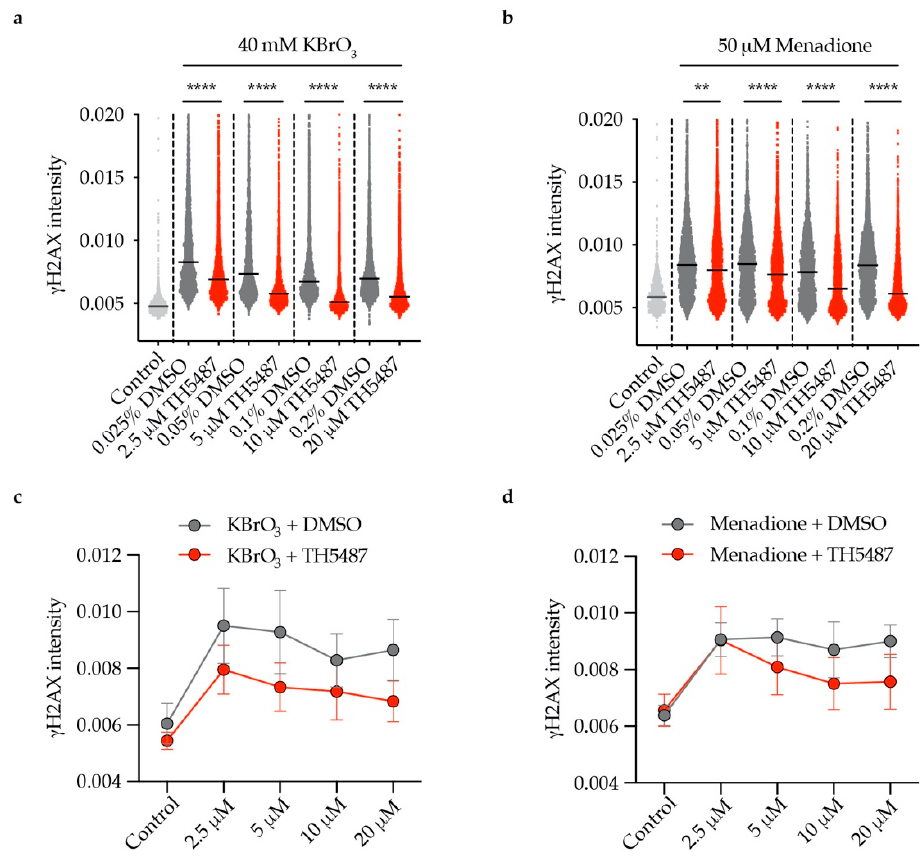
Figure 5. Concentration-dependent reduction of OGG1 incisions by TH5487. ( a , b ) Reduced nuclear γ H2AX intensity in U2OS cells treated with ( a ) KBrO 3 or ( b ) menadione and increasing concentrations of TH5487 for 1 h. ( c , d ) Mean values of (a) and (b). Scatterplots show data of at least 1000 (control) or 3300 (all other conditions) cells. Data are presented as median (a,b) and mean (c,d) ± SEM of two independent experiments with two technical repeats each. Statistical significance was determined using unpaired two-sided t -tests (** P < 0.01, **** P < 0.0001).